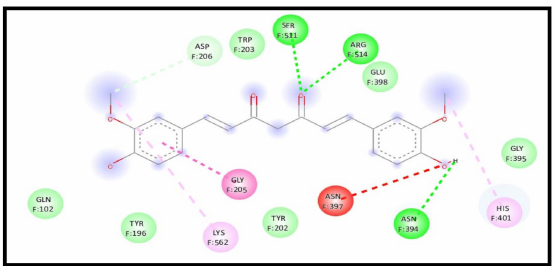
Figure 13. 2D interaction of curcumin–NLC with ACE 2 binding receptor (7KMB) in a complex.